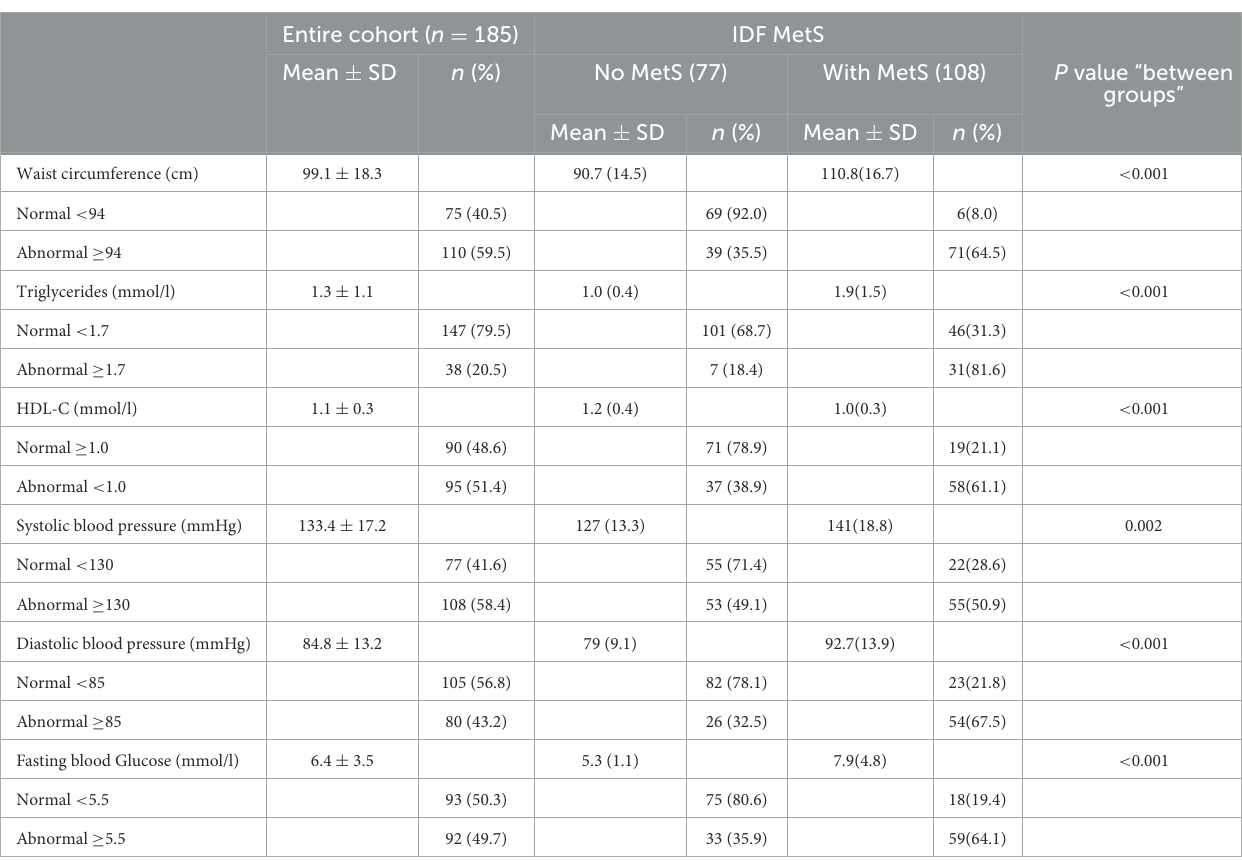
TABLE 3 The distribution of South African minibus taxi drivers by components of MetS.